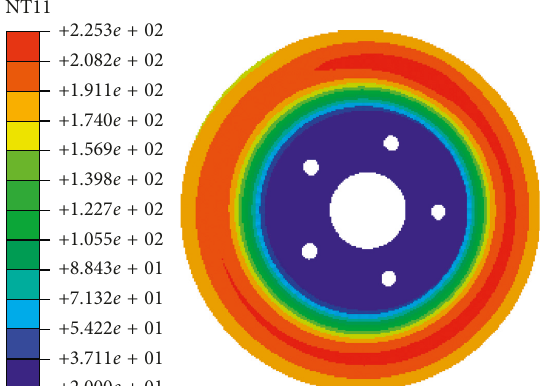
Figure 12: Temperature rise curve of the